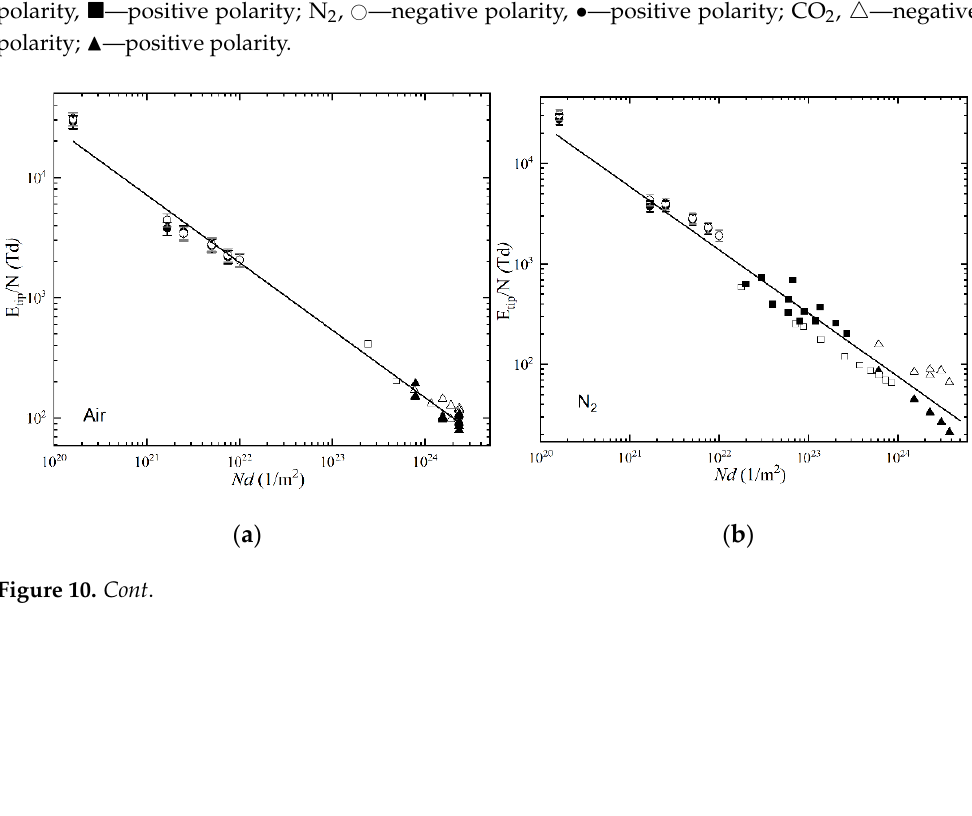
Figure 9. Field-time breakdown characteristic for different gases. Kinetic model, Equation (5), Nt f as a function of E / N : air, dotted line; N 2, solid dark line; CO 2 , solid gray line; SF 6 , dashed line. Experi- mental results obtained in the present work, Nt br as a function of E tip / N : air,  —negative polarity, ■ —positive polarity; N 2 , ○ —negative polarity, ● —positive polarity; CO 2 , △ —negative polarity; ▲ —positive polarity.